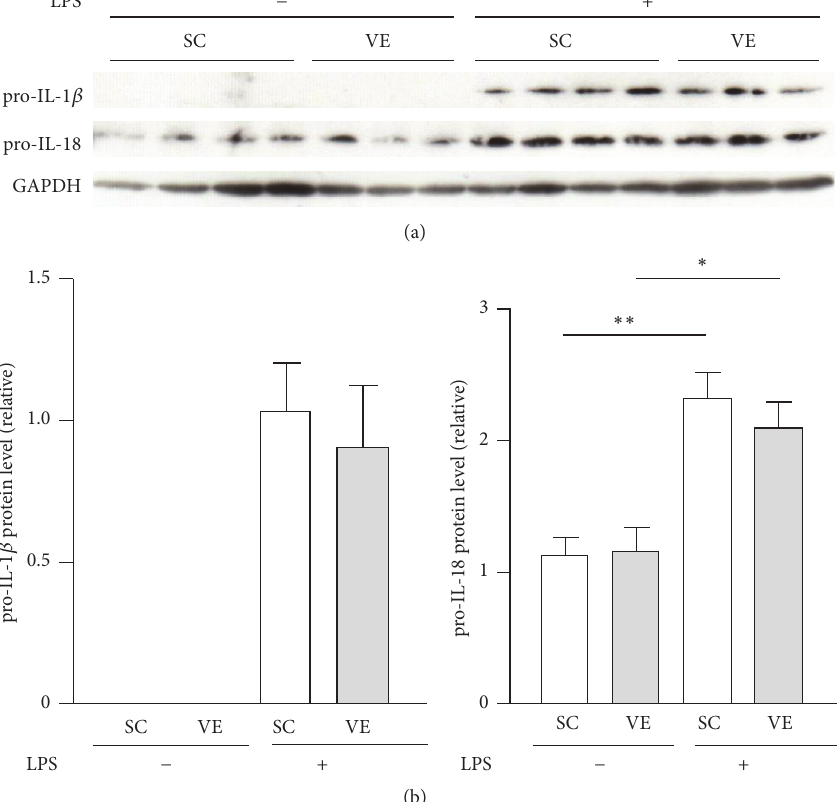
Figure 5: Effects of regular voluntary exercise (VE) on the protein levels of prointerleukin- (IL-) 1 𝛽 and pro-IL-18 in macrophages stimulated with or without lipopolysaccharide (LPS). Peritoneal-exudate macrophages isolated from the sedentary control (SC) and VE mice were cultured for 6h in the presence or absence of 100ng/mL LPS. (a) The protein levels of pro-IL-1 𝛽 and pro-IL-18 were analyzed by western blotting. (b) The protein levels are presented as ratios relative to the levels of glyceraldehyde 3-phosphate dehydrogenase (GAPDH). Mean ± standard error of the mean (SEM; 𝑛 = 3 - 4 ) values are provided. ∗ 𝑝 < 0.05 ; ∗∗ 𝑝 < 0.01 (by one-way analysis of variance [ANOVA] and the Bonferroni